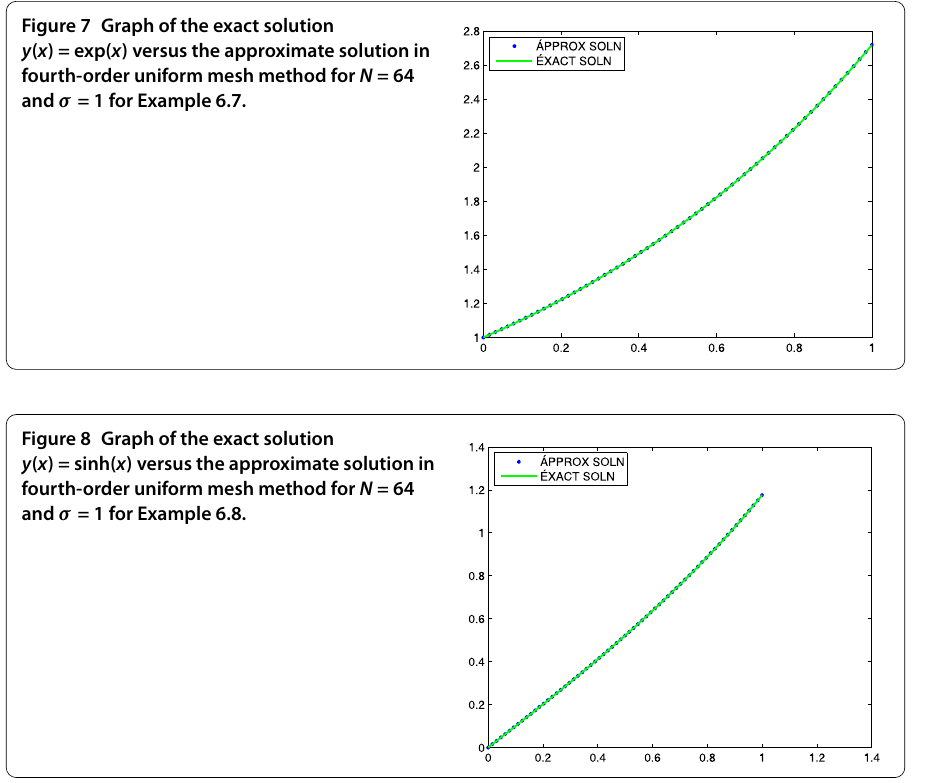
Figure 7 Graph of the exact solution y ( x ) = exp( x ) versus the approximate solution in fourth-order uniform mesh method for N = 64 and σ = 1 for Example 6.7.